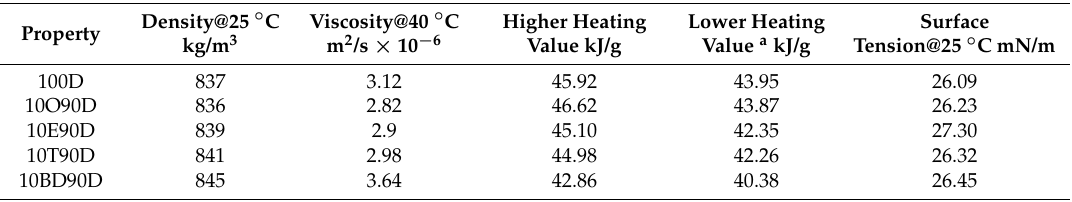
Table 1. Properties of fuel blends used in the engine test measured at Queensland University of Technology (QUT) adopted from [19].